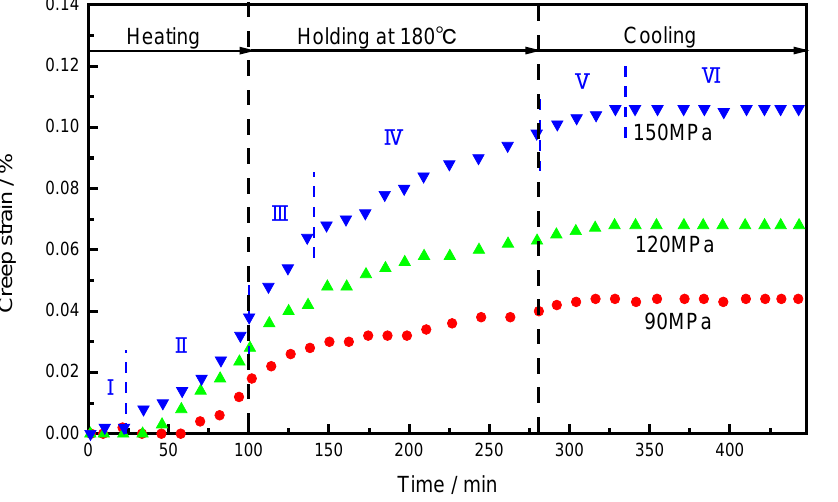
Figure 11. The creep deformation behaviors of the AA2024 aluminum alloy with various stresses during non-isothermal process. during non-isothermal process.